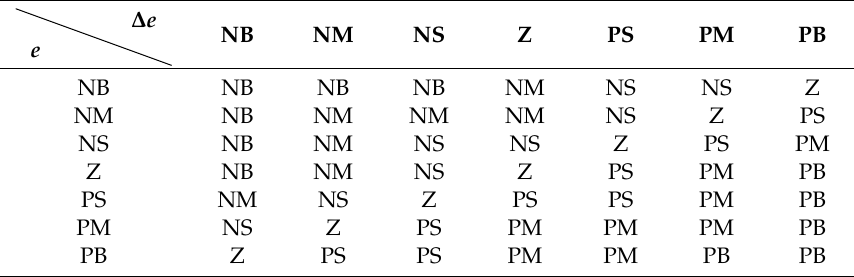
Table 4. Rule Table for fuzzy logic